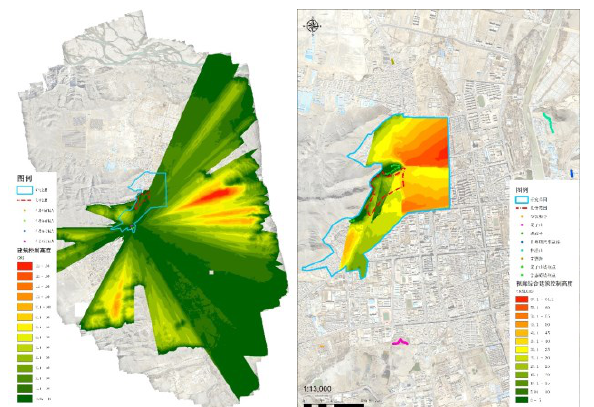
Figure 5. Height control requirement analysis of Shigatse